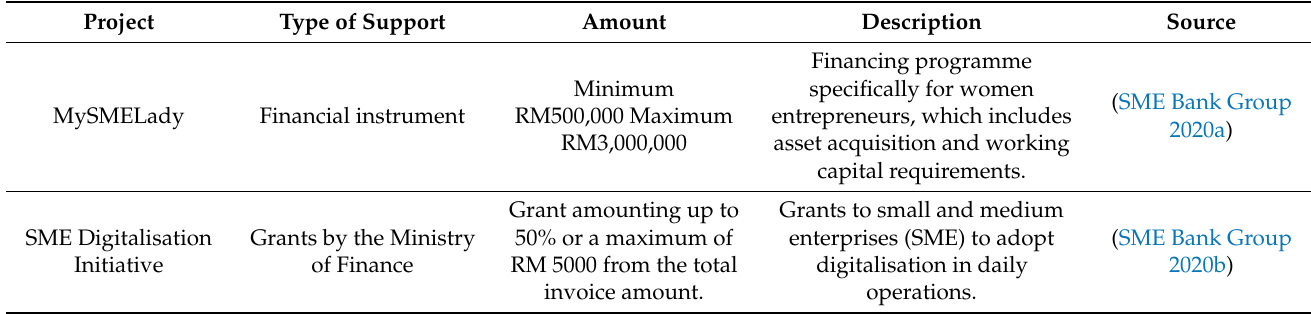
Table 1. Examples of responsible financing projects in